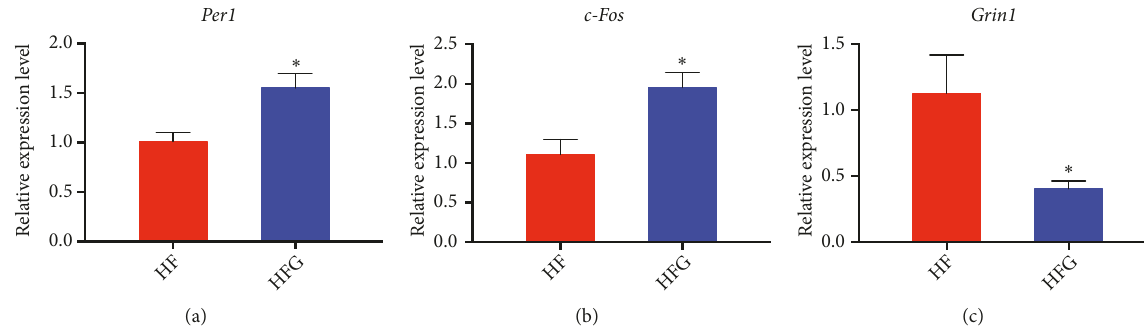
Figure 6: RT-qPCR verification of significant genes between the HF group and the HFG group. (a) Per1 ; (b) c-Fos ; and (c) Grin1 . HF: high-fat diet without genistein; HFG: high-fat diet with genistein. Data are expressed as means ± S.E.M. (n=5/group). Mean values were significantly different between HF group and the HFG group: ∗ p <